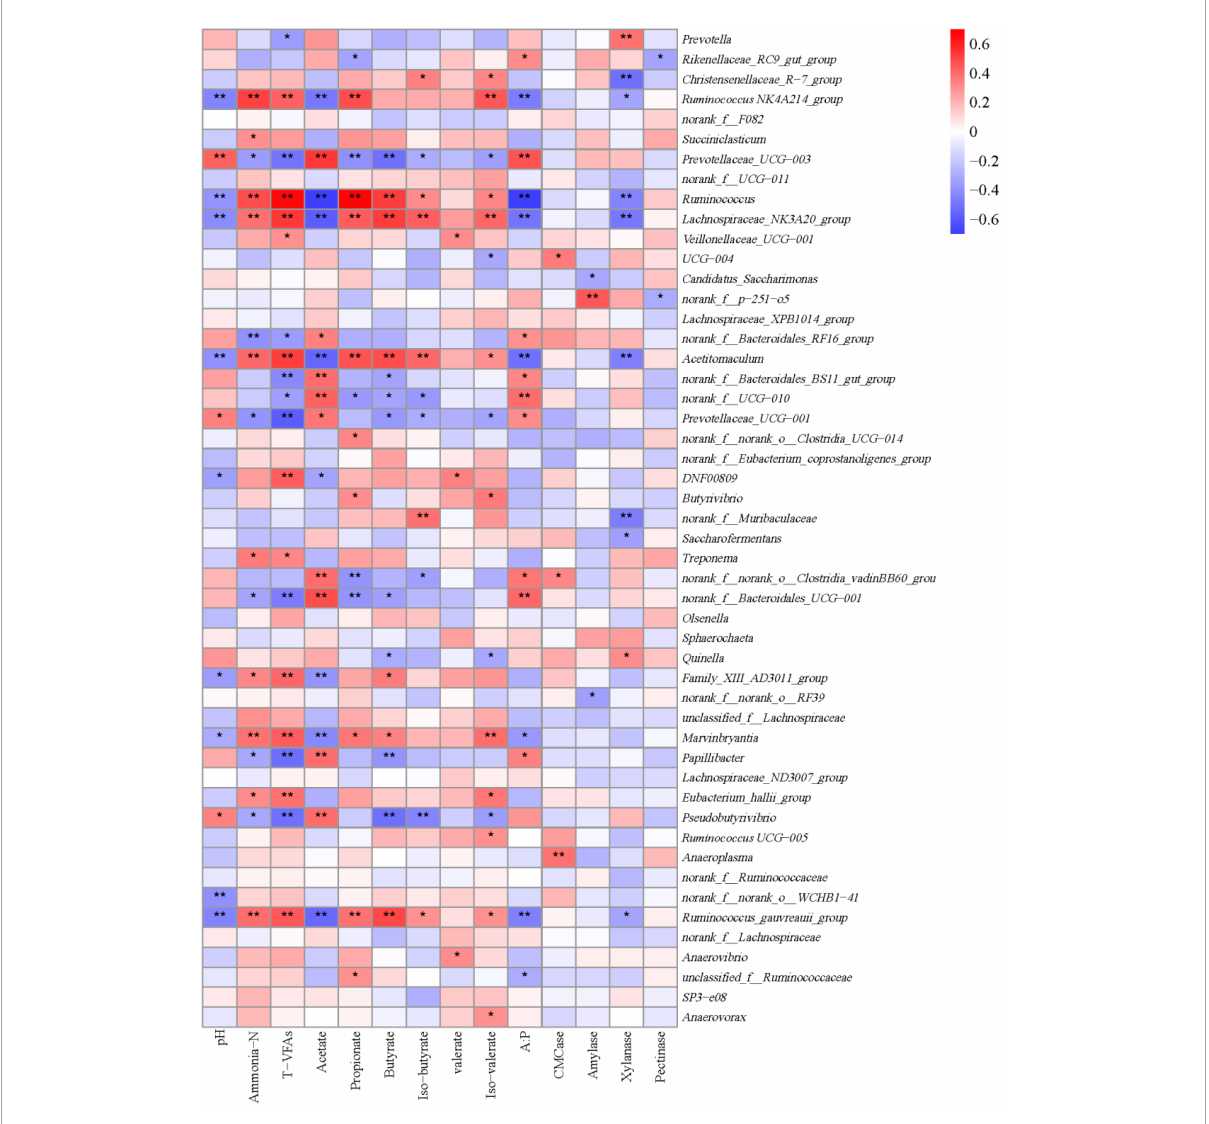
FIGURE7 Spearman’s rank correlation analysis between the top 50 bacteria at the genus level and rumen fermentation parameters. * P < 0.05, and ** P < 0.01 according to Spearman’s rank correlation